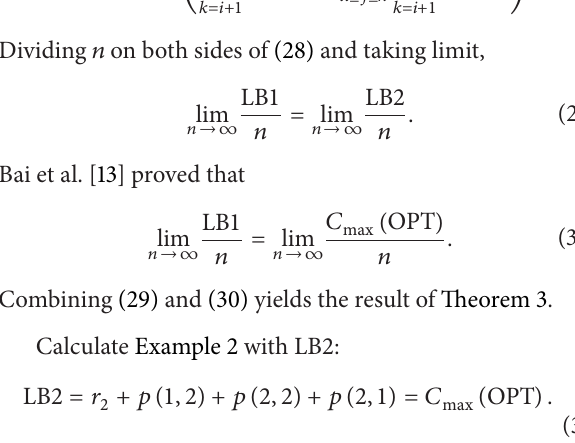
Table 2: Performance comparison of MGS and DSJF